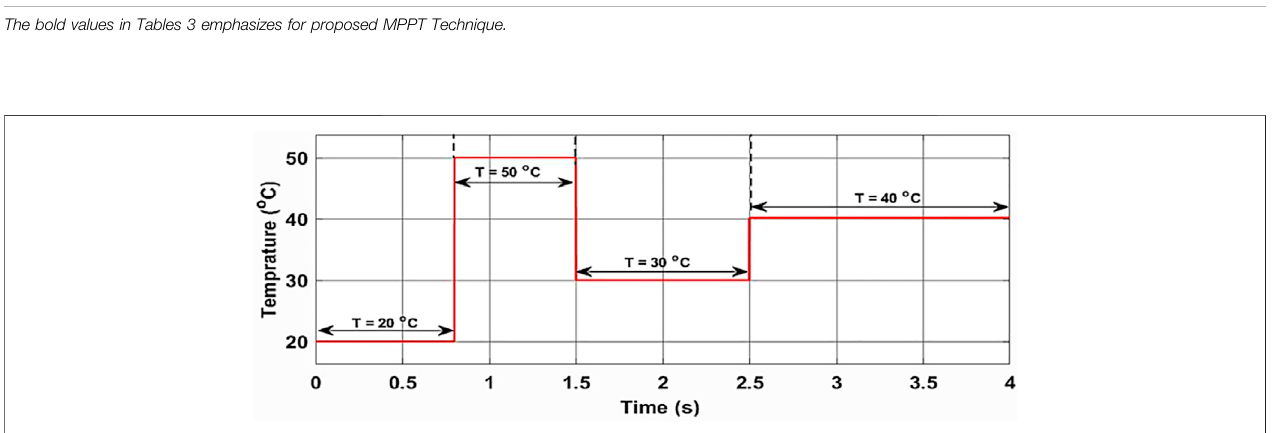
FIGURE 9 | Temperature pattern for